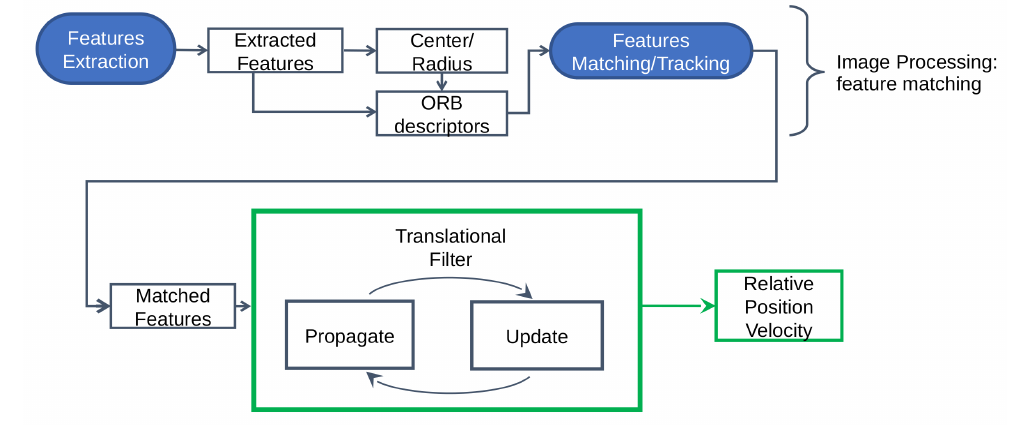
Figure 2. Relative terrain navigation algorithm. The figure relates to Figure 1 showing the adopted baseline for this work in terms of IP-navigation